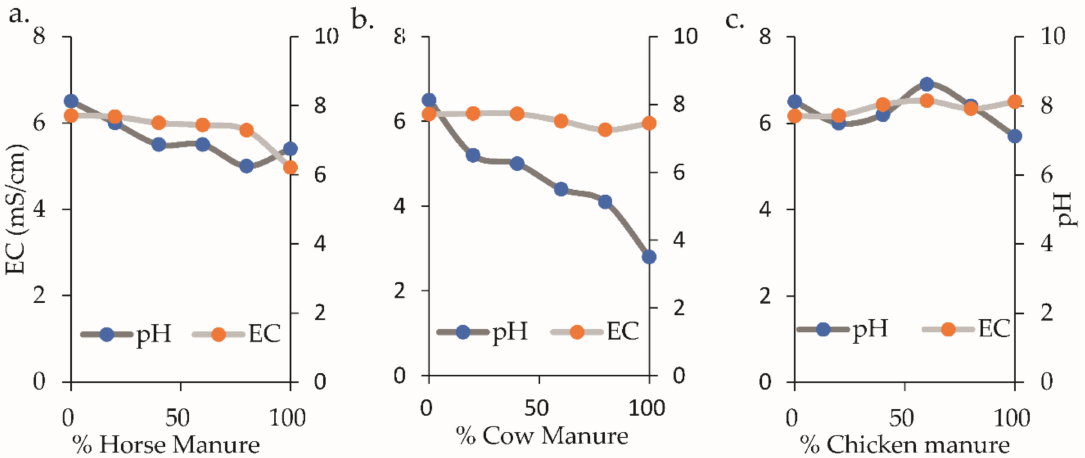
Figure 2. pH and EC in the combination of food waste manure and animal manure: ( a ), food waste manure and horse manure; ( b ), food waste manure and cow manure; and ( c ), food waste manure, and chicken